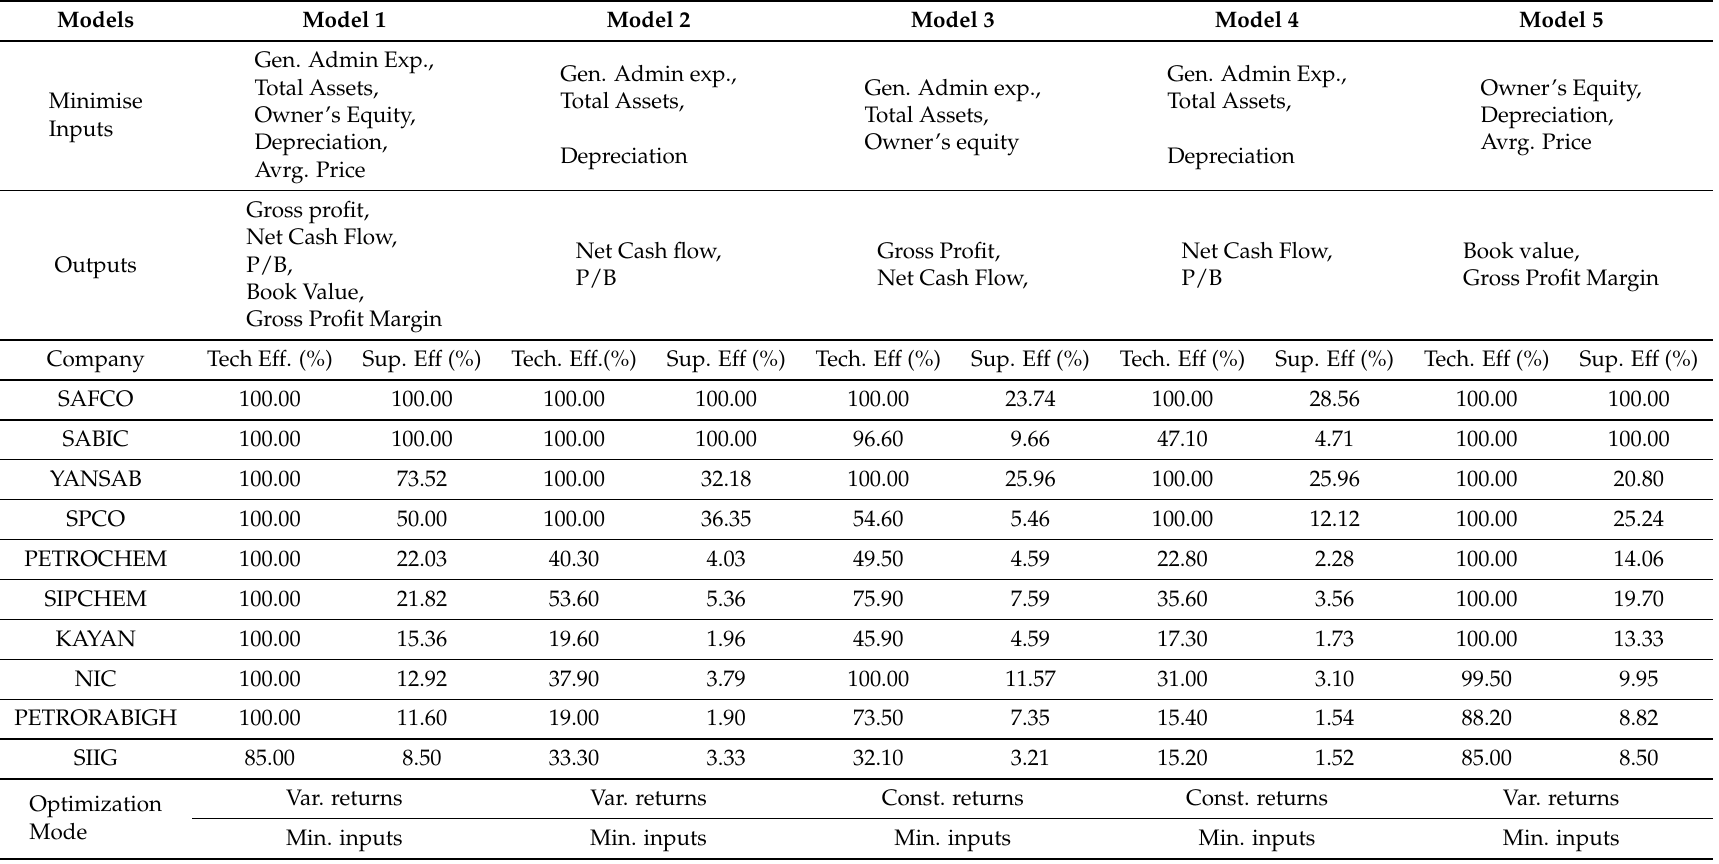
Table 2. Technical and super-efficiencies with 5 different data envelopment analysis (DEA)